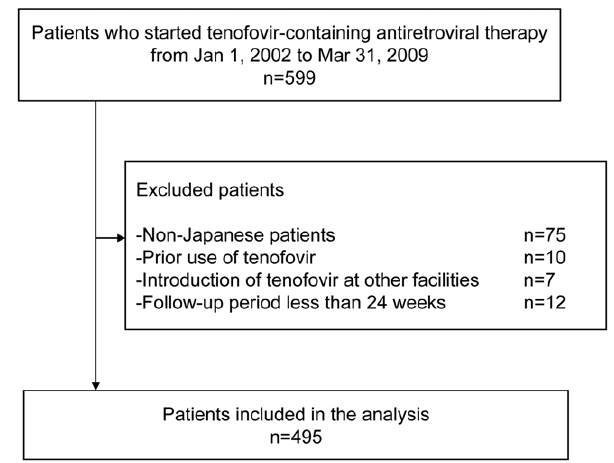
Figure 1. Flow diagram of patient